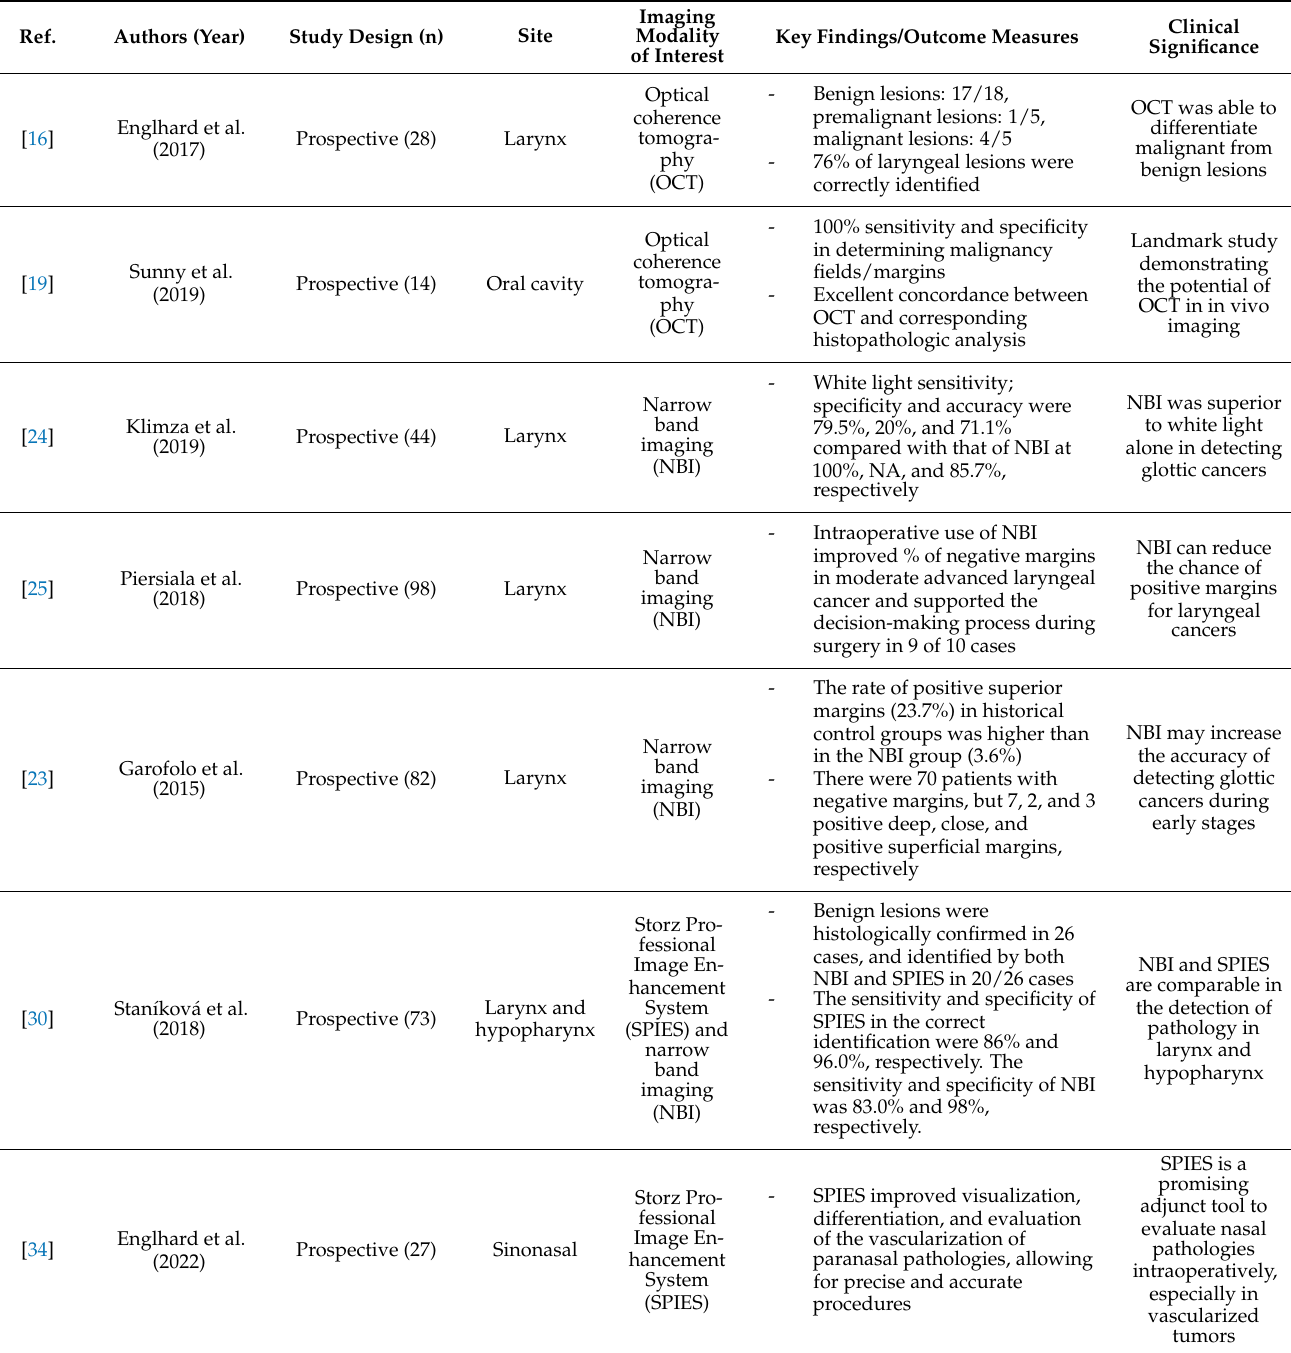
Table 3. Studies from optical coherence tomography to the Storz Professional Image Enhancement